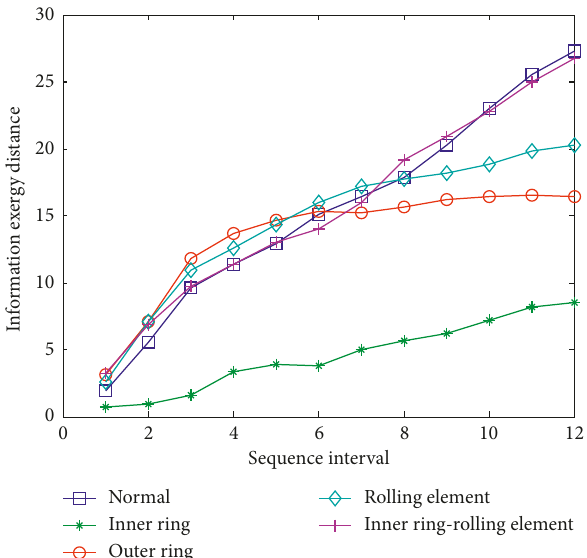
Figure 6: Information exergy distance of inner ring